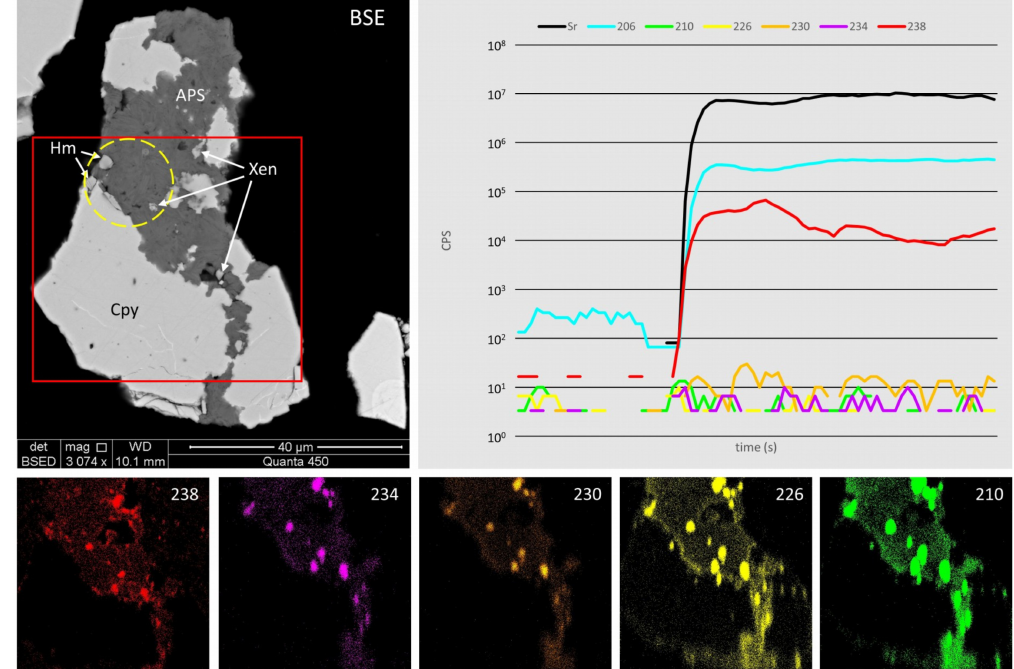
Figure 14. The BSE image (top left), single time-resolved LA-ICP-MS depth profile data (top right), and nanoSIMS images (bottom) of an assemblage of APS phase(s) with chalcopyrite (Cpy), hematite (Hm), and xenotime (Xen) in sample 10CLD42. Maps of 238 U, 234 U, 230 Th, 226 Ra, and 210 Pb are presented. The red outline is the nanoSIMS mapping area, the yellow circle is the location of a 15 µ m-diameter LA-ICP-MS spot. Only 238 U gives a convincing response by LA-ICP-MS, but all five RNs are clearly present on the nanoSIMS maps with elevated backgrounds in the APS phases and xenotime but not in